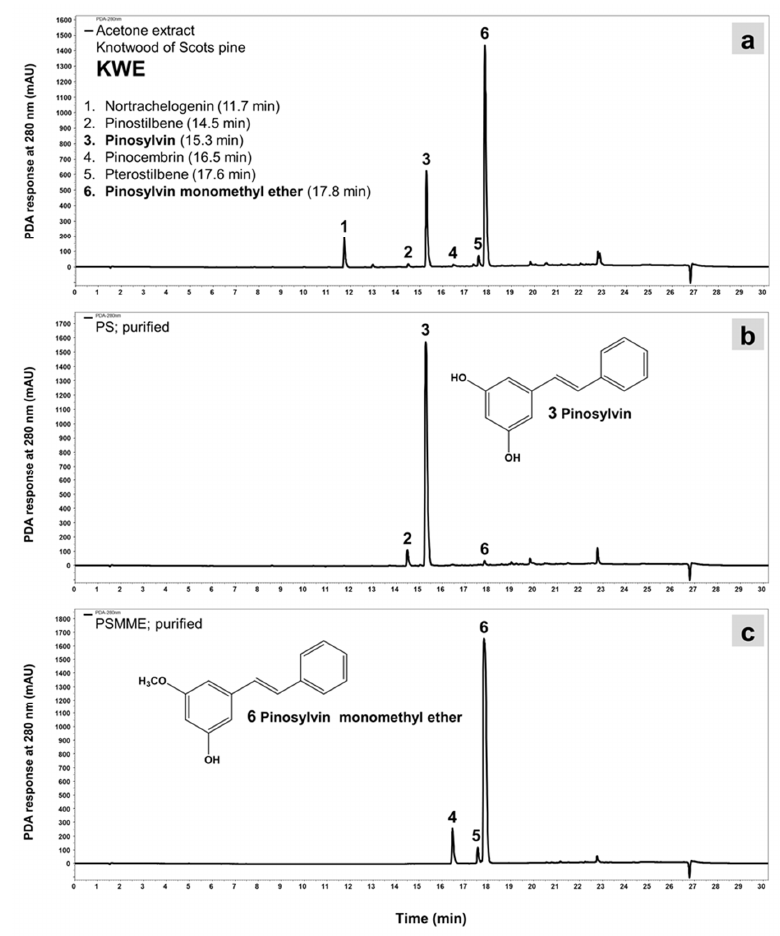
Figure 2. High-performance liquid chromatography-potato dextrose agar (HPLC-PDA) chromatograms of Scots pine ( Pinus sylvestris ). ( a ) Homogenized acetone extract of knotwood (KWE), ( b ) pure pinosylvin used for the antifungal assay and ( c ) pure pinosylvin monomethyl ether used for the antifungal assay.